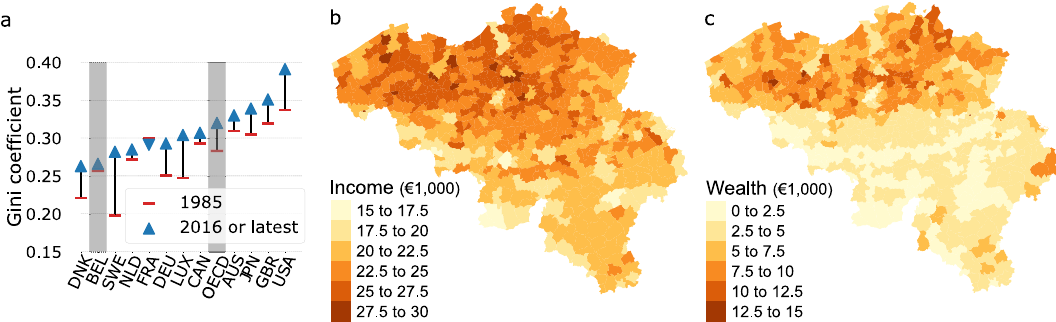
Fig. 1 Measures for economic equality in Belgium. Panel a : The Gini coef fi cient of disposable income (post taxes and transfers) for 12 OECD countries for the mid-1980s and for 2016 or the latest available year. Belgian and the OECD average incomes are highlighted. Note that a Gini of 0(1) stands for complete (in)equality. Panel b : The observed median income per municipality in the data for all clients (aged 18 – 60) in 2006. Panel c : The observed median fi nancial wealth per municipality in the data for all clients (aged 18 – 60) in 2006. HUMANITIES AND SOCIAL SCIENCES COMMUNICATIONS| (2022) 9:51